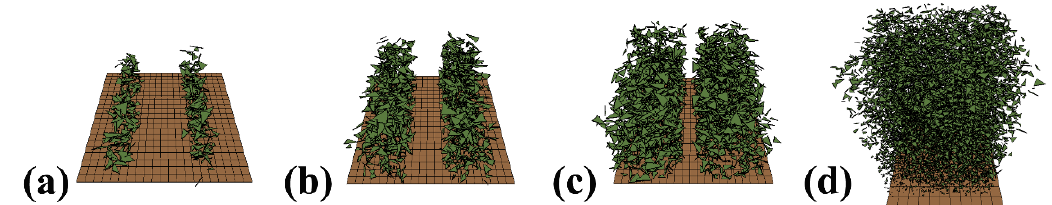
Table 1. Values required when constructing abstract scenes with computer graphics.